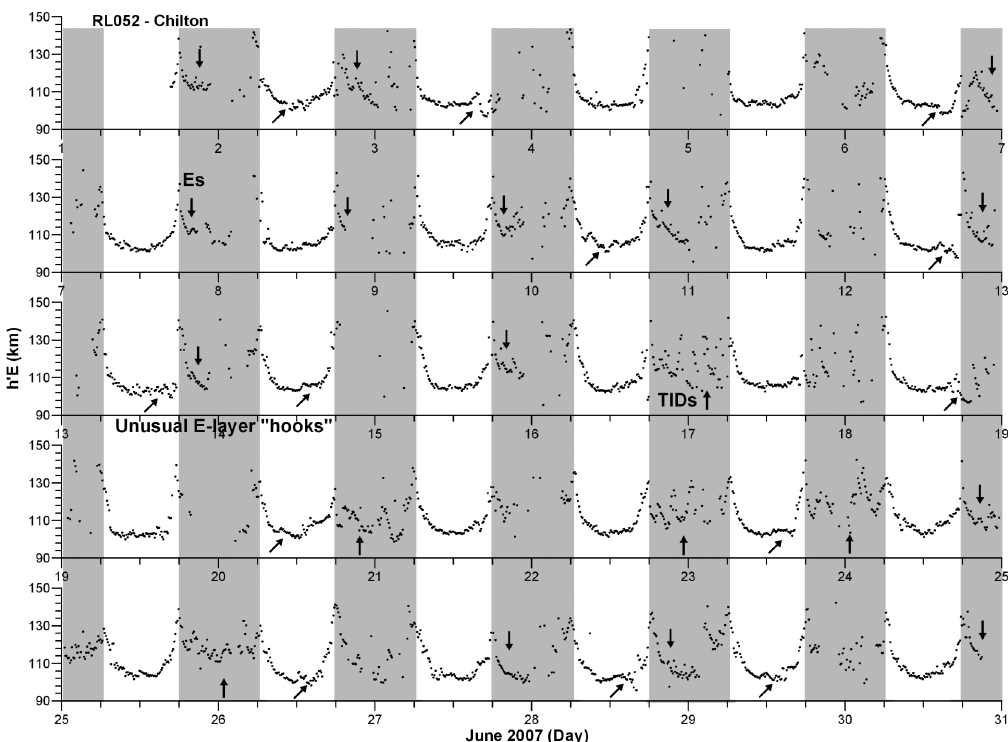
Fig. 5. E -region precision group height measurements at Chilton, UK as function of time for June 2007. The horizontal axes represent time (Universal Time) and the vertical axes represent virtual height (km). The grey shaded areas indicate night-time measurements and the arrows point out significant inter-diurnal height varia- tions as hook shaped or trains of height